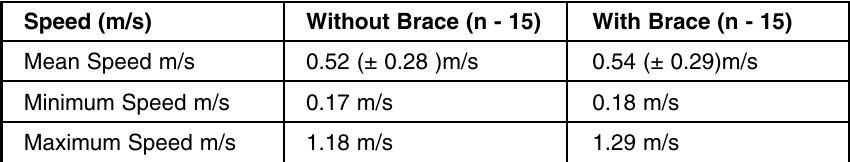
Table 3: Stride length with and without FECK brace